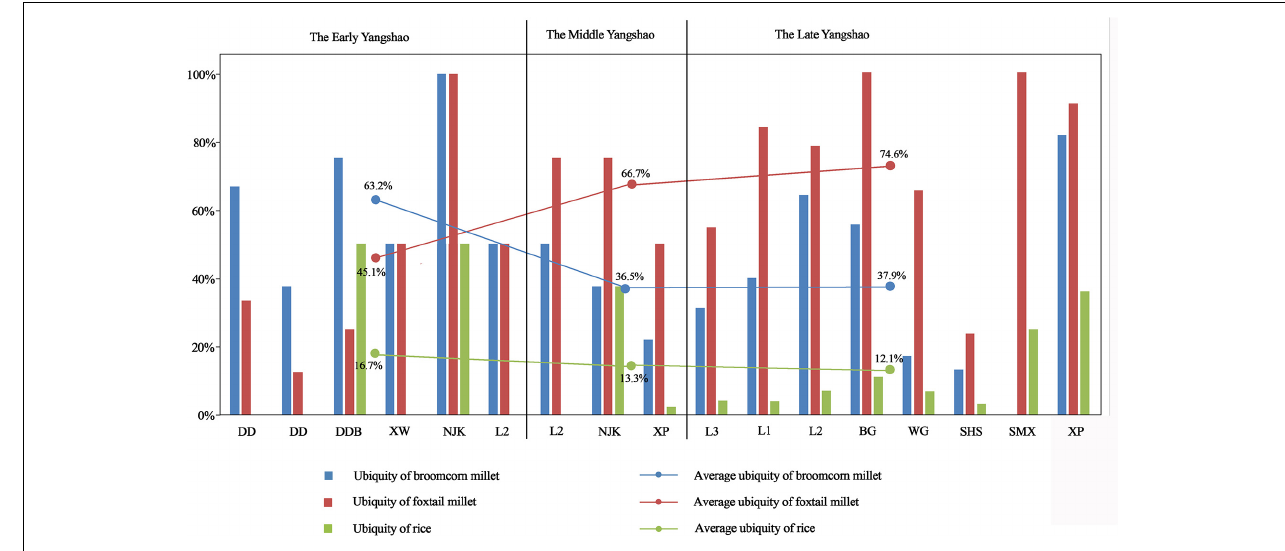
FIGURE 3 | Trends in the ubiquity of broomcorn millet and foxtail millet throughout the Yangshao Culture in eastern and western Henan